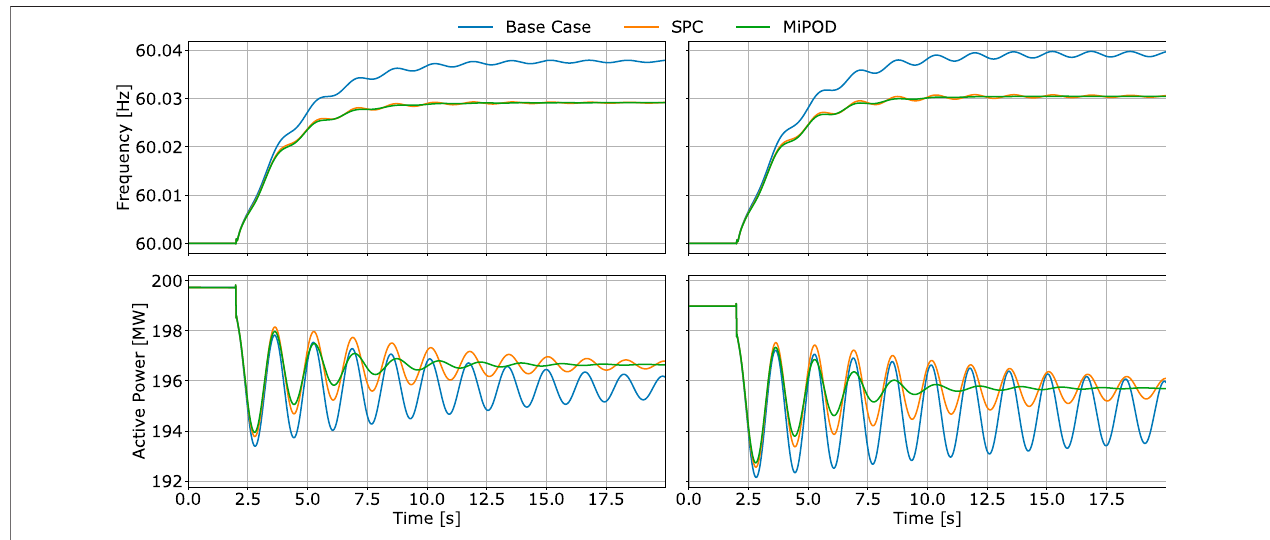
FIGURE 16 | System frequency and active power fl ow at B08 after a sudden 5% increase of reactive power demand by L9 for 2 random operating points.